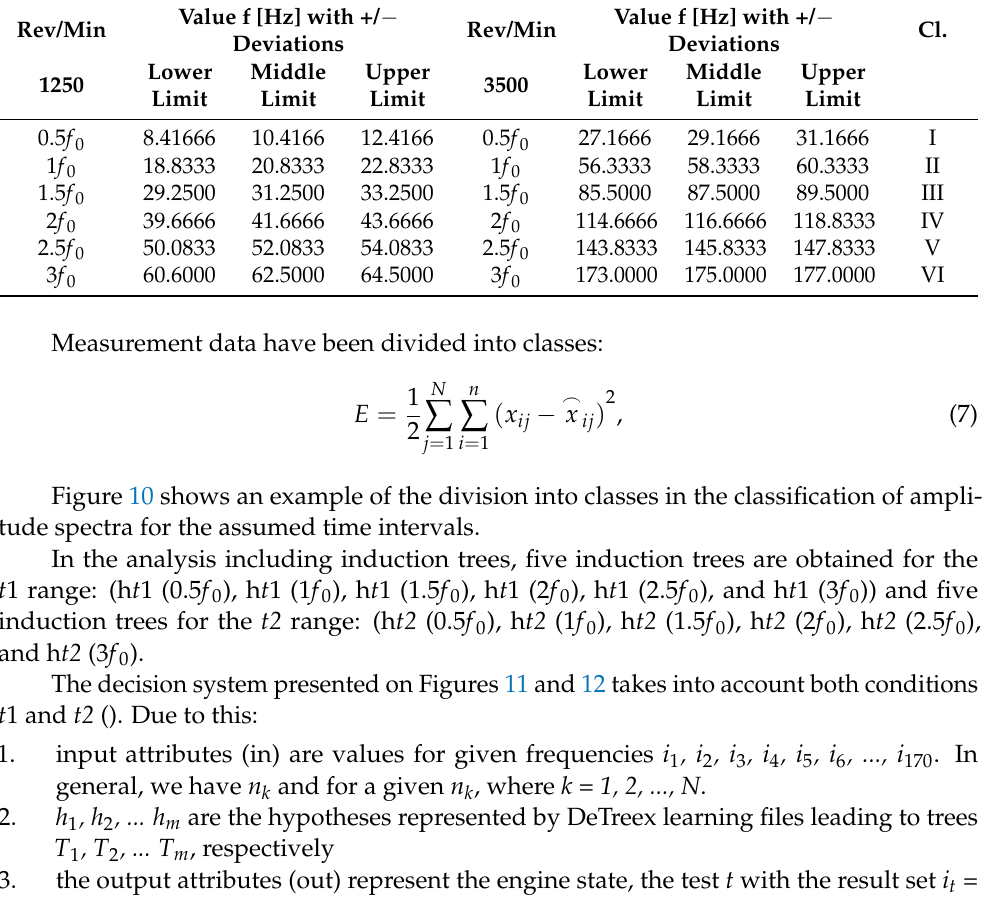
Table 3. Adopted harmonic frequency ranges of the signal spectrum. Value f [Hz] with +/ Rev/Min